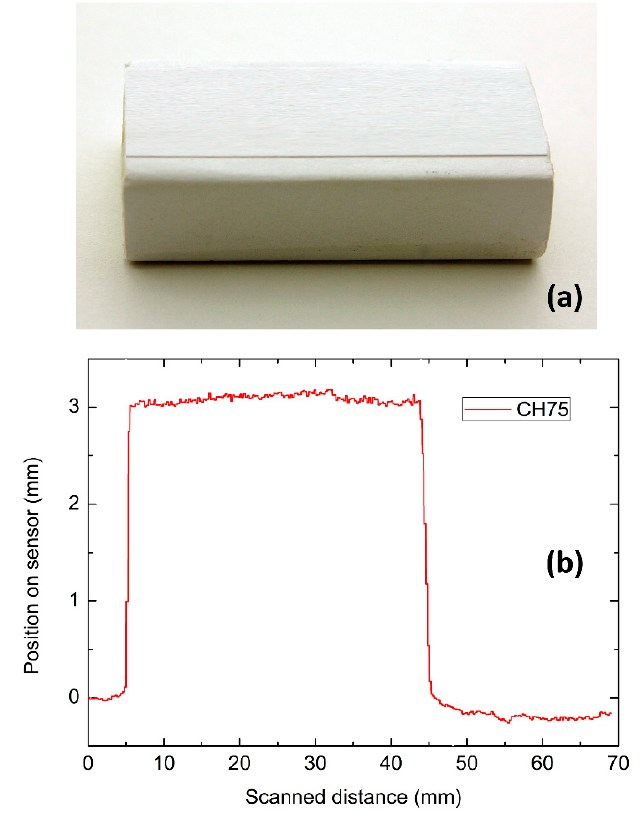
Figure 2. ( a ) Photograph of a white rubber object; ( b ) 3D object profile representation for the individual detection of channel 75 from the 128 PSD array sensor.